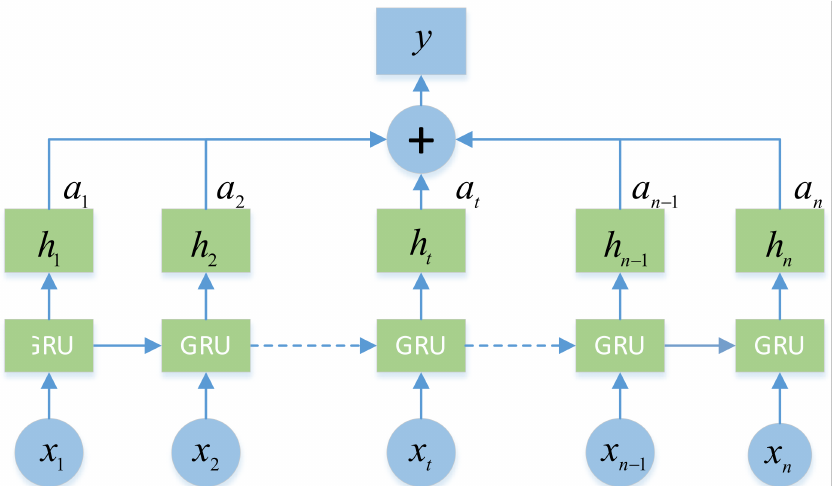
Figure 7. At-GRU structure, where n represents the input sequence length, x t represents the input of the t -th layer, h t represents the output of layer t, a t represents the weight of the timing feature calculated by the attention mechanism, and y represents the output of At-GRU, which is weighted by the output of each layer of the